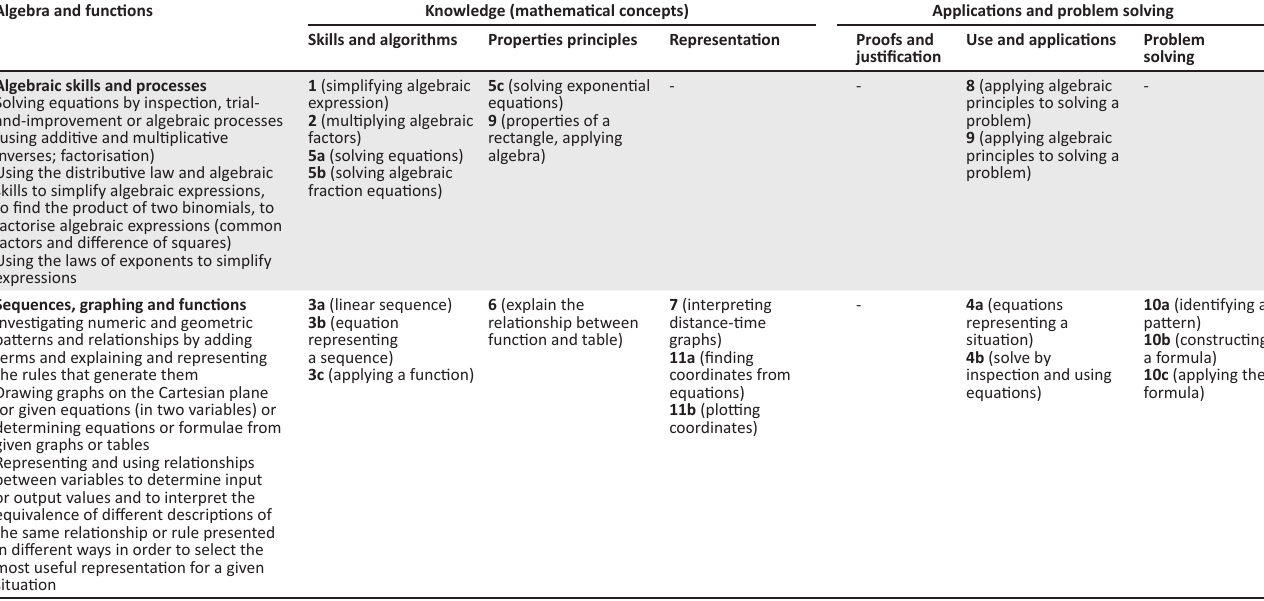
TABLE 1−A3: Items allocated to Usiskin’s dimensions (Grade 9). Algebra and